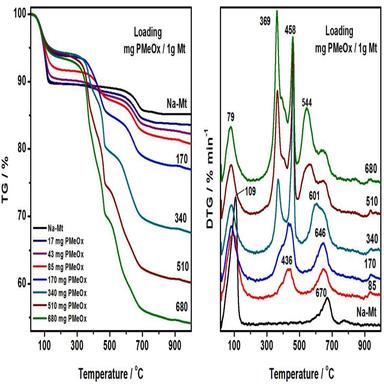
TG and DTG curves of PMeOx-Mt prepared with different initial amounts of PMeOx, indicated in the figure.